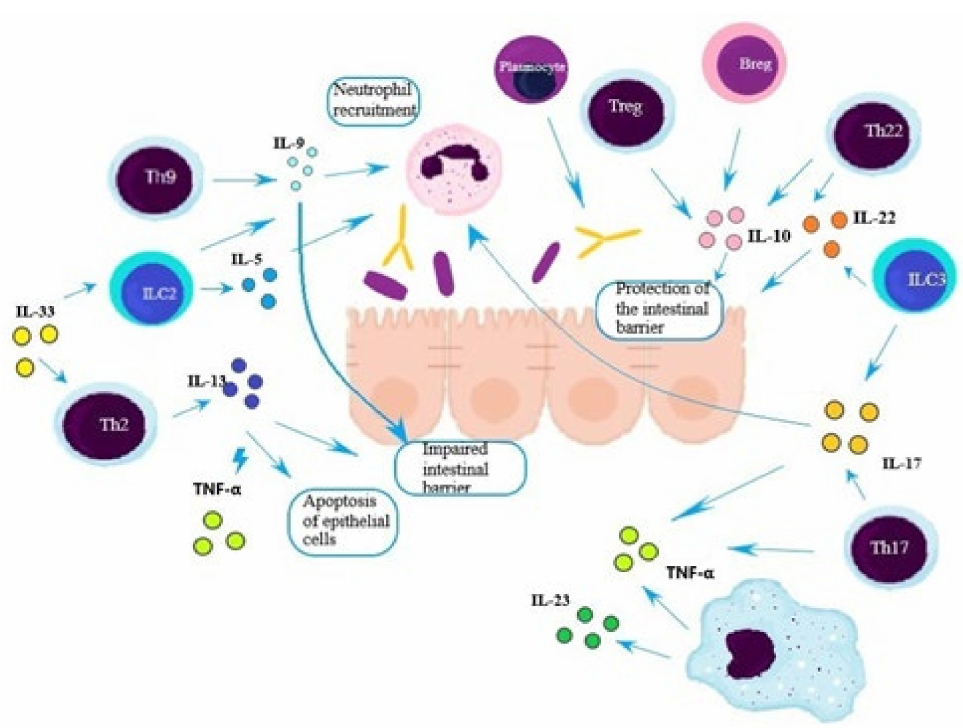
Figure 3. The role of immune cells in the development of ulcerative colitis (UC). Among patients with UC, an increased number of Th2, Th9, and Th17 lymphocytes, as well as ILC2 and ILC3, is observed. The cytokines secreted by these cells contribute to the impairment of the intestinal barrier function through increased expression of claudin-2 and increased apoptosis of epithelial cells. Additionally, cytokines stimulate the migration and degranulation of neutrophils and further activation of immune cells. Activated plasma cells secrete antibodies, including those against gut microbiota inducing chemokines and IL-1 β [5,27,33,45]. At the same time, the number and/or activity of Breg, Treg, and Th22 cells is decreased, which leads to reduced protection of the intestinal barrier